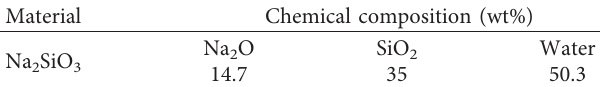
Table 2: Composition of sodium